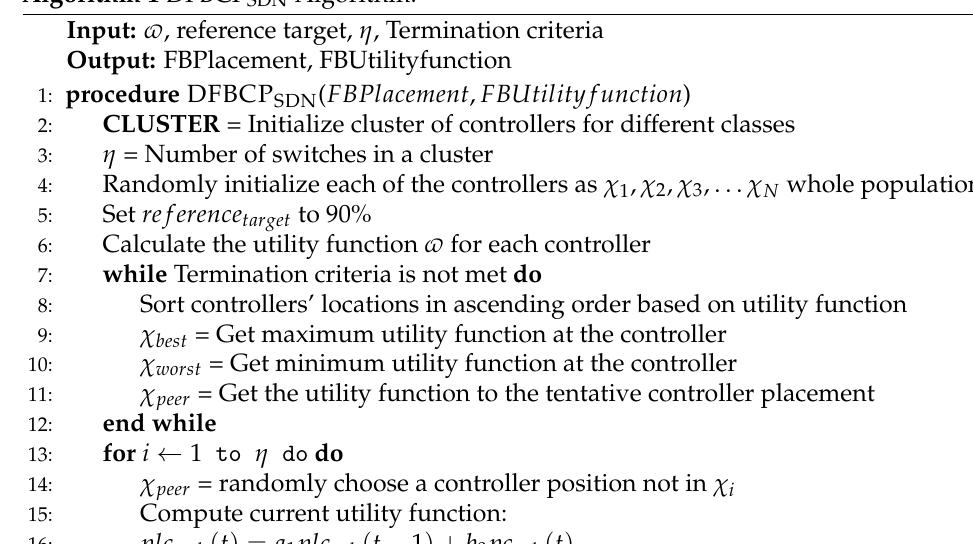
Algorithm 1 DFBCP SDN